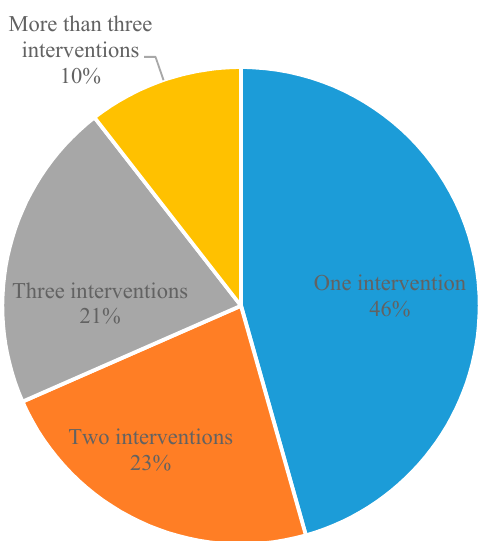
Figure 3. Numbers of studies per intervention that stimulates physical activity in parks. Source: Authors’ own multi-database literature search.